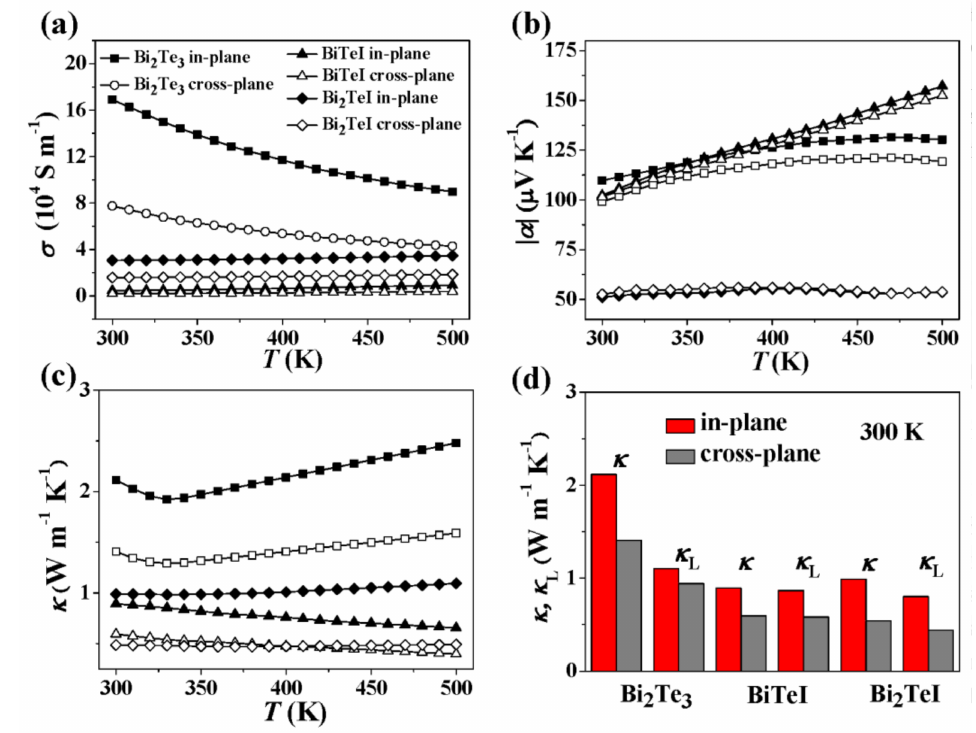
Figure 3. Temperature dependence of ( a ) electrical conductivity, ( b ) Seebeck coefficient, ( c ) thermal conductivity, and ( d ) comparison of the thermal conductivity and lattice thermal conductivity of Bi 2 Te 3 , BiTeI, and Bi 2 TeI at 300